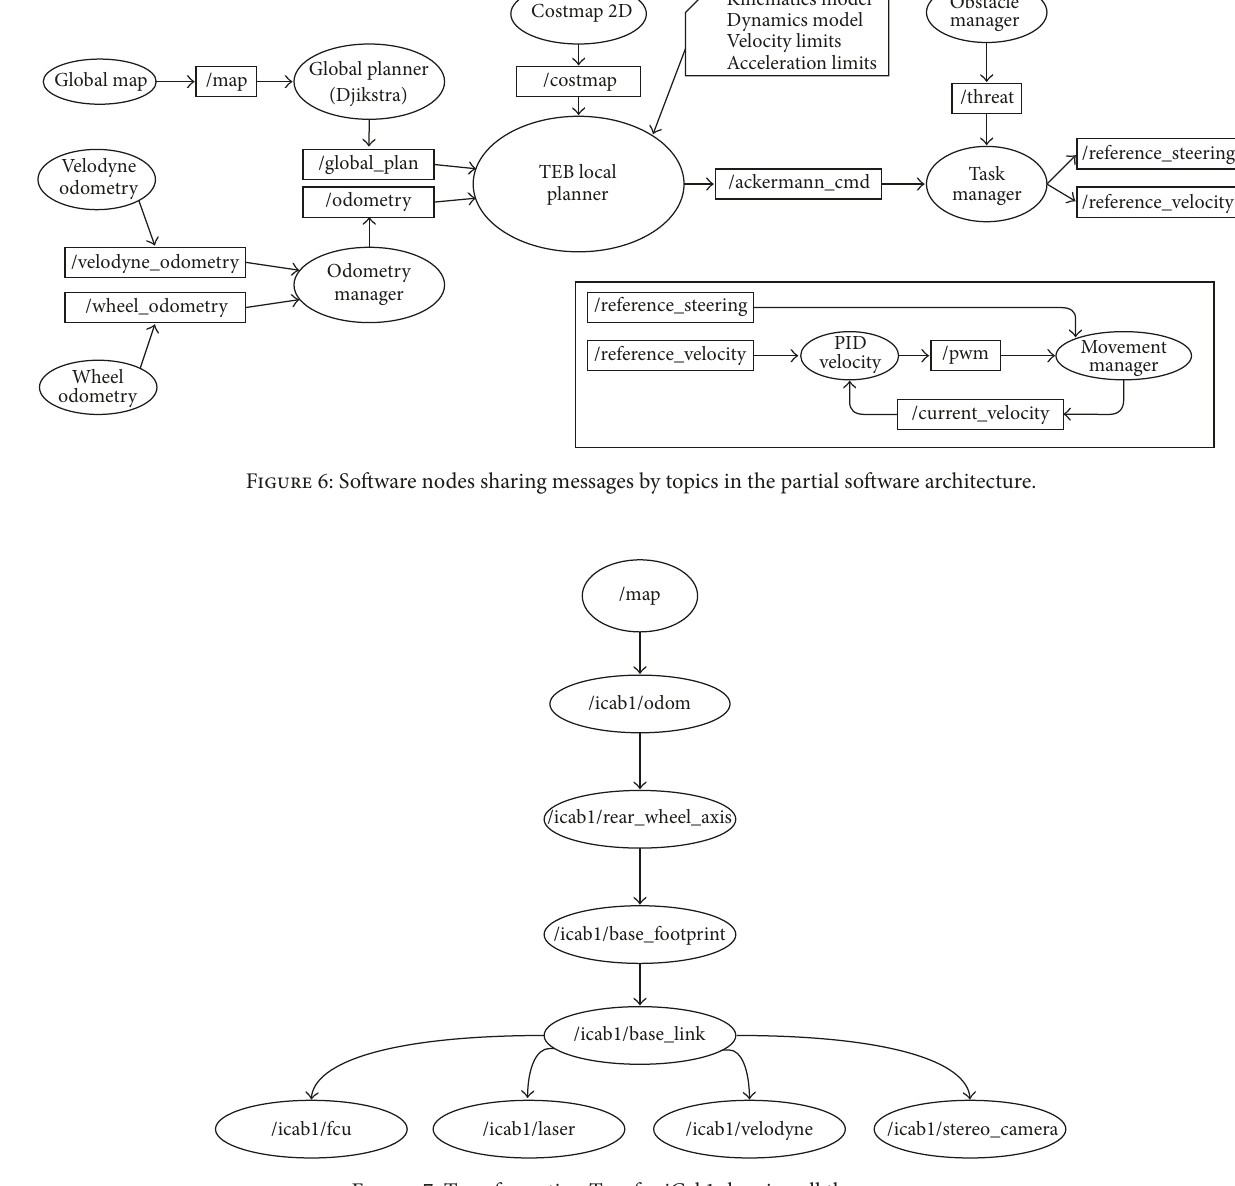
Figure 7: Transformation Tree for iCab1 showing all the